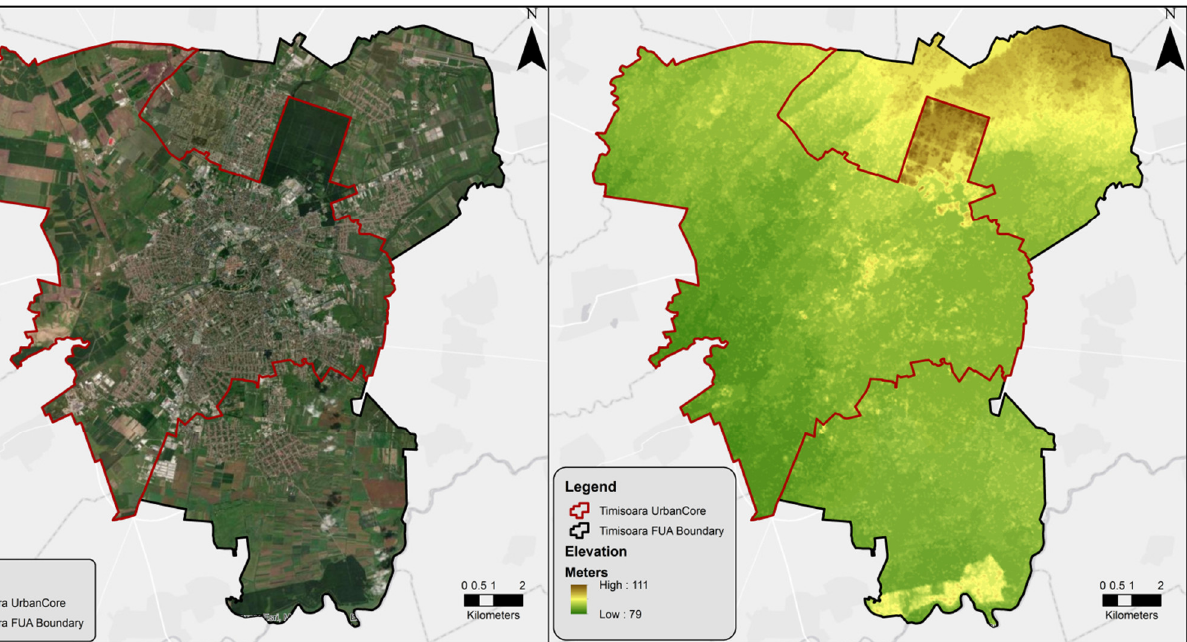
Table 3. Summary of vulnerability level variation between 2006 and 2018 in Timișoara FUA.